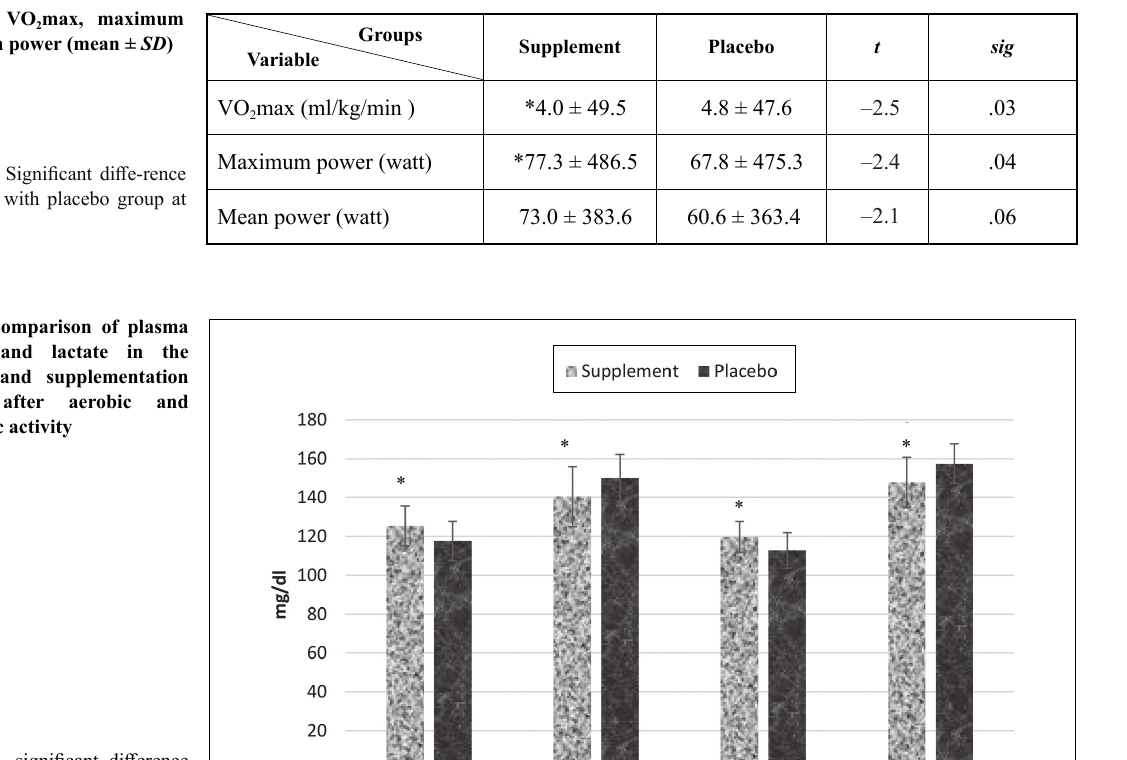
Note. * – significant difference compared with placebo group at p ≤